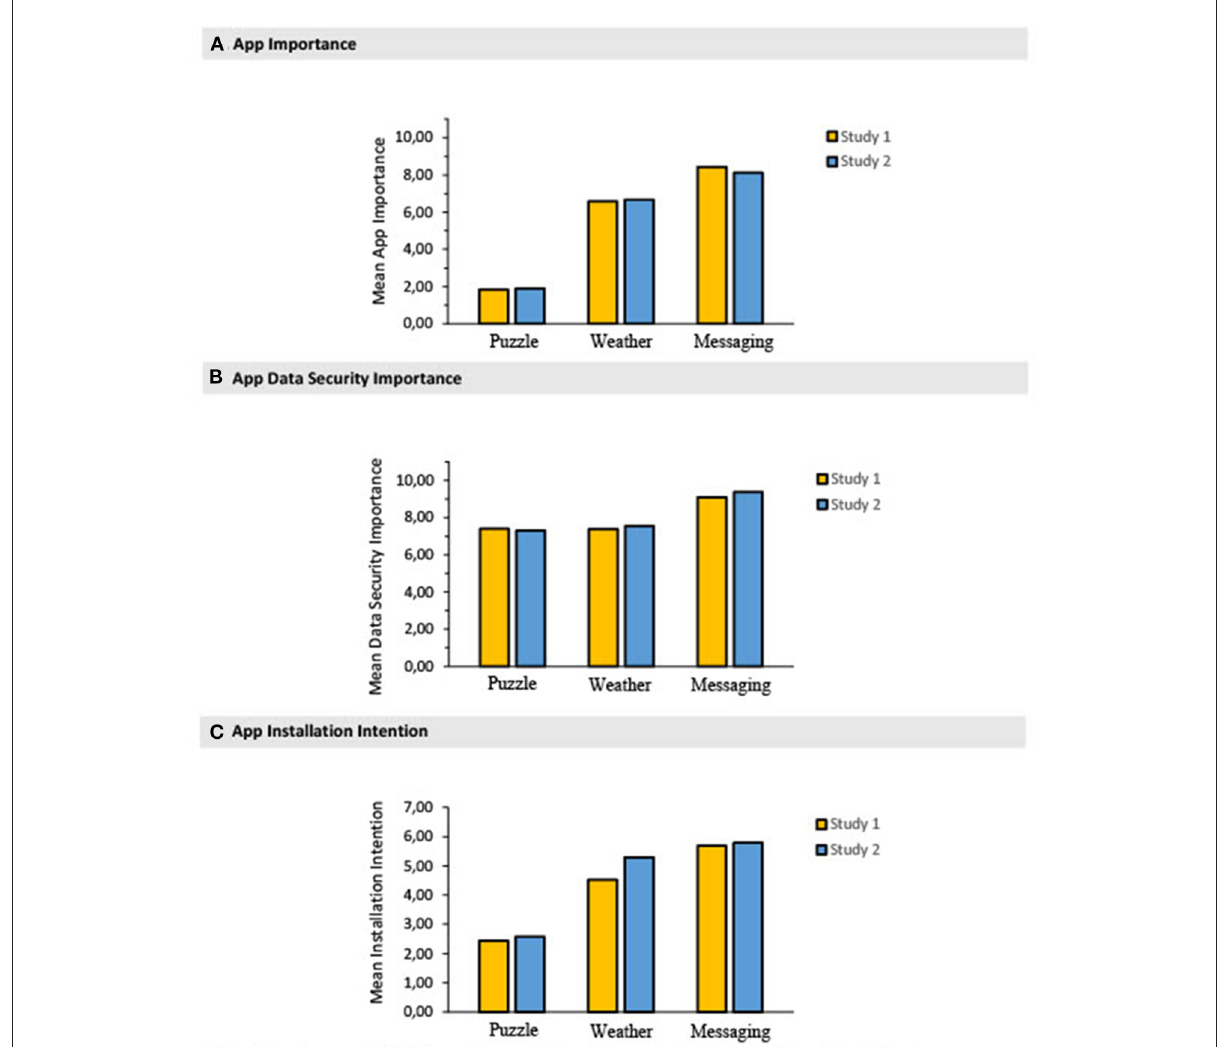
FIGURE1 Mean perceived app importance (A) , app data security importance (B) , and app installation intention (C) . Error bars with 95% confidence intervals corrected for within-subject designs were omitted from the graphs because the bars were too narrow to be